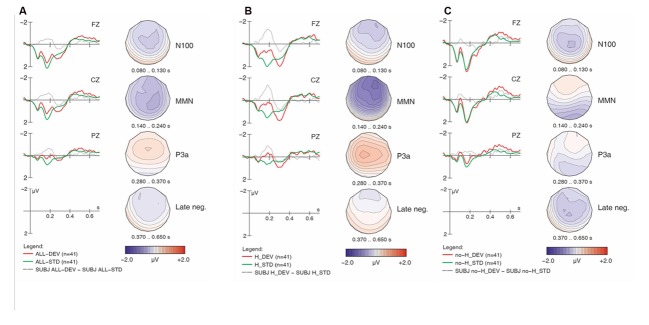
Overall ERP mismatch effects: collapsed across all sub-conditions and both groups (A); collapsed across both groups for [h] items (B); collapsed across both groups for non-[h] items (C). Negativity is plotted upward; vertical axis at 0 ms indicates stimulus onset. Voltage maps depict the distribution of the difference wave in the time windows used for statistical analysis.